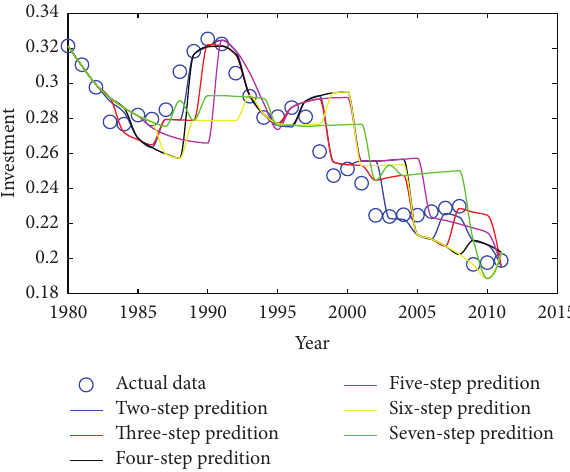
Figure 4: The predictions of interest rate based on empirical model in the case of Δ𝑡 = 1 .